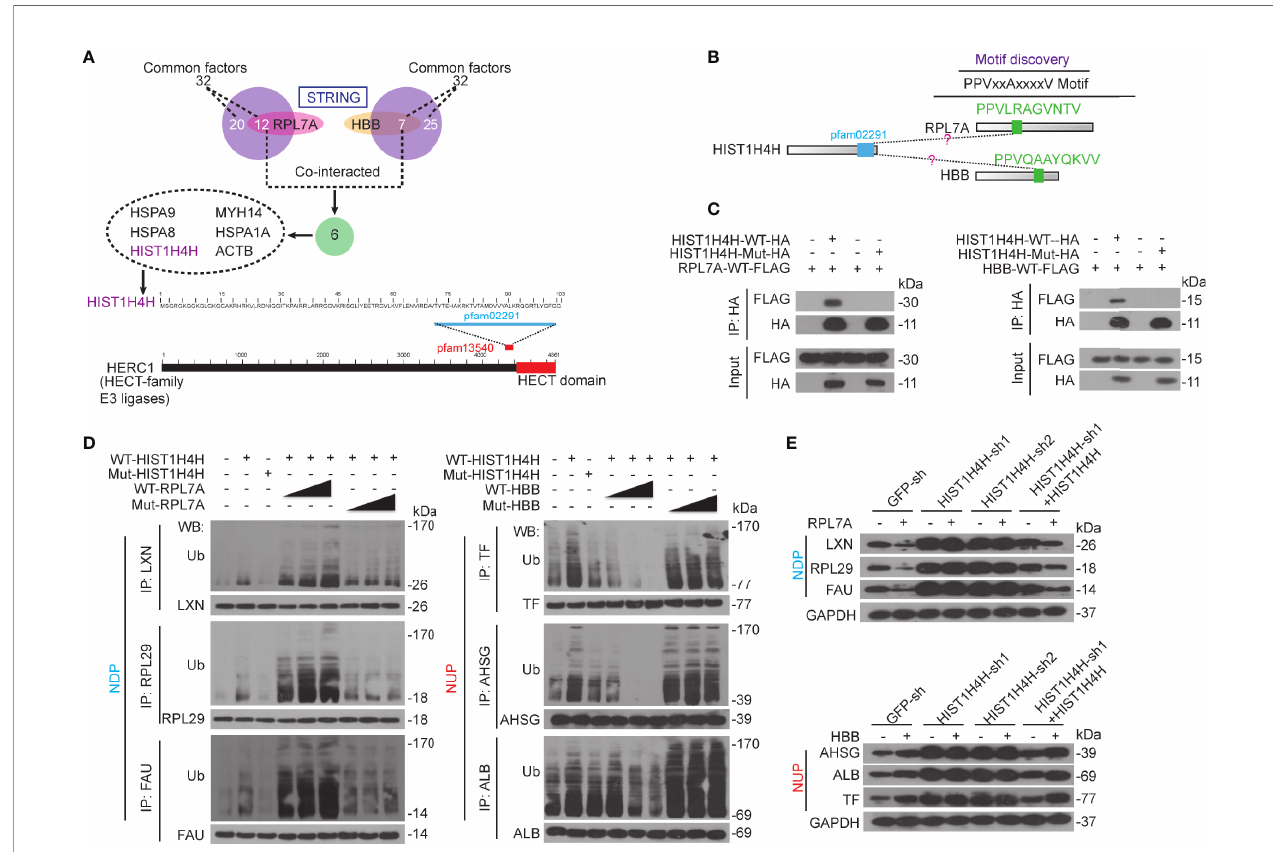
FIGURE 6 | RPL7A and HBB regulated NDP and NUP via HIST1H4H. (A) HIST1H4H was predicted to co-interact with RPL7A and HBB. STRING was performed to reveal the interactions among HIST1H4H, RPL7A and HBB. The domain within HIST1H4H was aligned using Blastp, and the data were extracted from Uniprot. (B) The PPVxxAxxxxV motif was predicated to be similar between RPL7A and HBB, and the bioinformatics was conducted using the CDD database and Blastp. (C) RPL7A and HBB interacted with HIST1H4H. WT or mutant HIST1H4H (without functional pfam02291), as indicated, was co-expressed with WT RPL7A and HBB, respectively in Bel-7402 cells. The exogenous HIST1H4H-HA was immuno-precipitated by anti-HA antibodies, and co-immuno-precipitation of exogenous RPL7A-FLAG and HBB-FLAG was visualized by WB using anti-FLAG antibodies. (D) RPL7A and HBB oppositely controlled ubiquitination of NDP and NUP that mediated by HIST1H4H. Bel-7402 cells were co-overexpressed with WT or mutant HIST1H4H (without functional pfam02291) and WT or mutant RPL7A/HBB (without functional PPVxxAxxxxV motif), as indicated. Ubiquitination of NDP/NUP was fi rstly immuno-precipitation of NDP/NUP by the corresponding antibodies, and then visualized by anti-Ub antibodies using WB. (E) RPL7A and HBB regulate NDP and NUP expression via HIST1H4H. The protein expression of NDP and NUP were measured by WB in Bel-7402 cells with or without HIST1H4H knocked down or overexpressed, in the presence or absence of RPL7A (upper) or HBB (lower) overexpression. Images of WB are representative ones of 3 independent